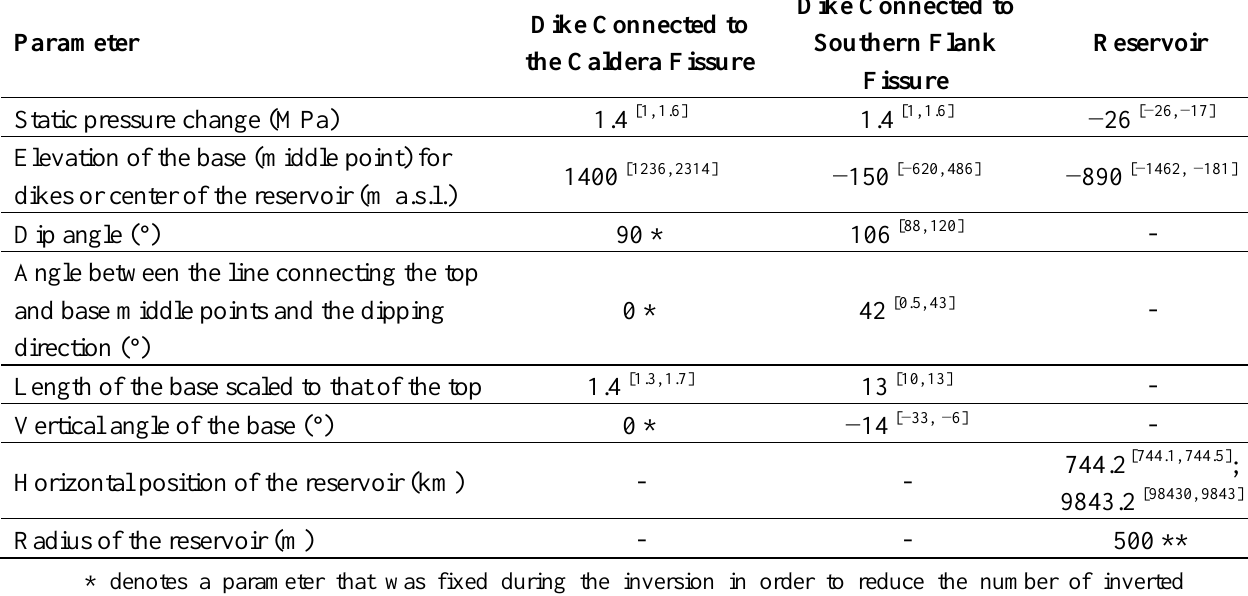
Table 2. Best-fit parameters for the most likely model using two dikes and a spherical reservoir. The 95% confidence intervals on the 12 inverted parameters are shown (Figure S6, [41]) . Parameter